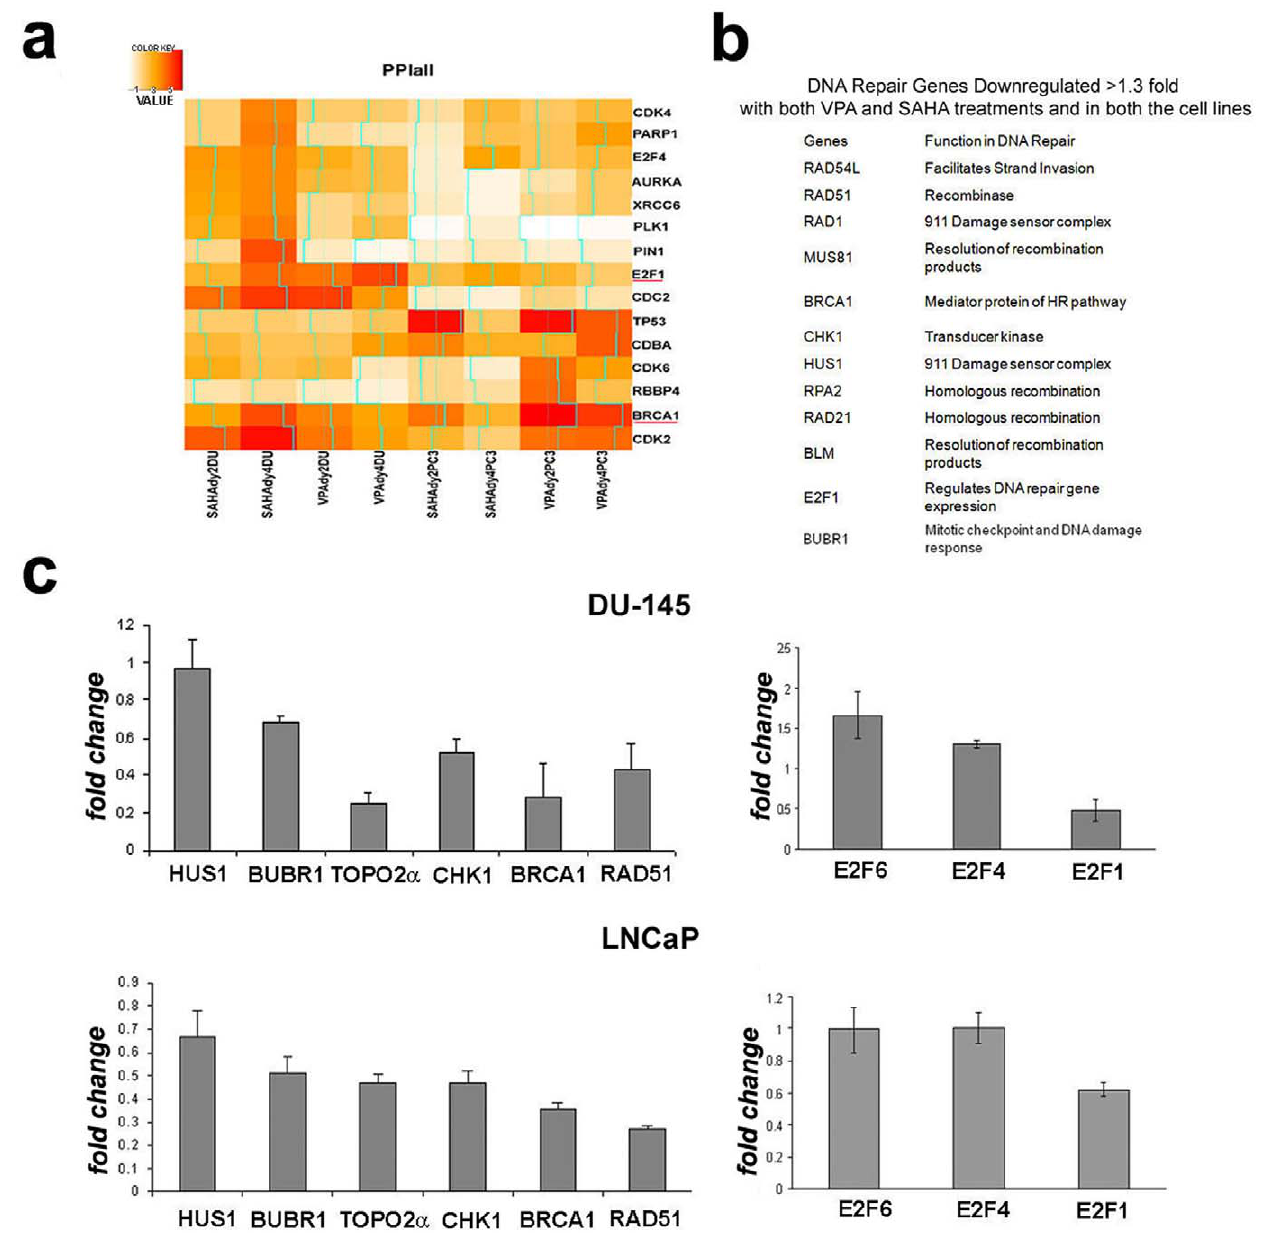
Figure 1. Analysis of Functional Annotation (AFA) in HDACi treated PCa cells. a) DU145 and PC3 cells were treated with two different HDACis (vorinostat (SAHA, 1 m M), and VPA (Valproic acid, 1 mM) for incubation periods (2days and 4days). AFA reveals down-regulation of genes involved with DNA damage and response (see Table 1). AFA results for protein-protein interaction indicate BRCA1 and E2F interacting networks are affected by HDAC inhibition. Color code represents as 10 -n the p- values obtained from the Wilcoxon rank-sum test. b) DNA repair genes downregulated $ 1.3 fold in both PC3 and DU-145 cells upon treatment with both VPA and vorinostat. c) Validation of the AFA was done by a Q-PCR analysis on a subset of genes downregulated upon 1.5 mM VPA treatment. Results are depicted as fold change over untreated control